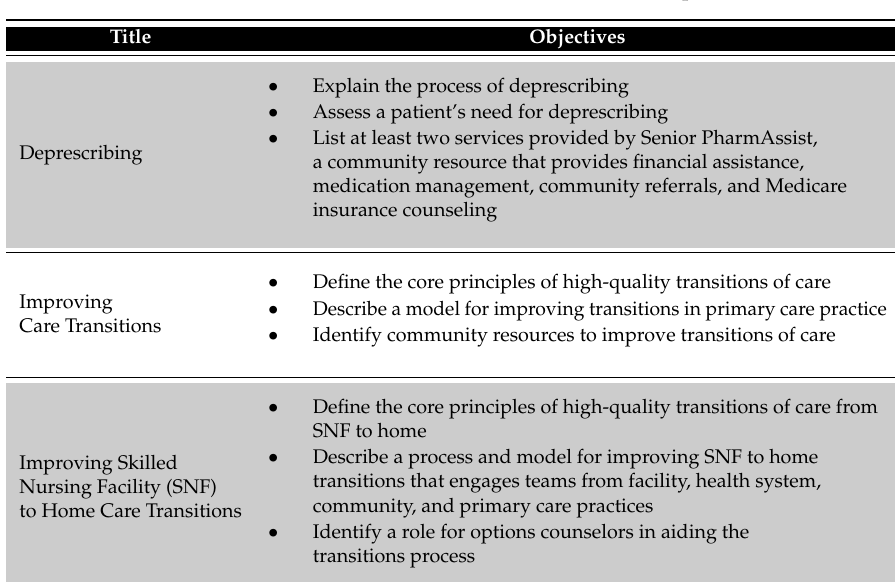
Table 1. Geriatric resource teams ( GRT) webinar topics.